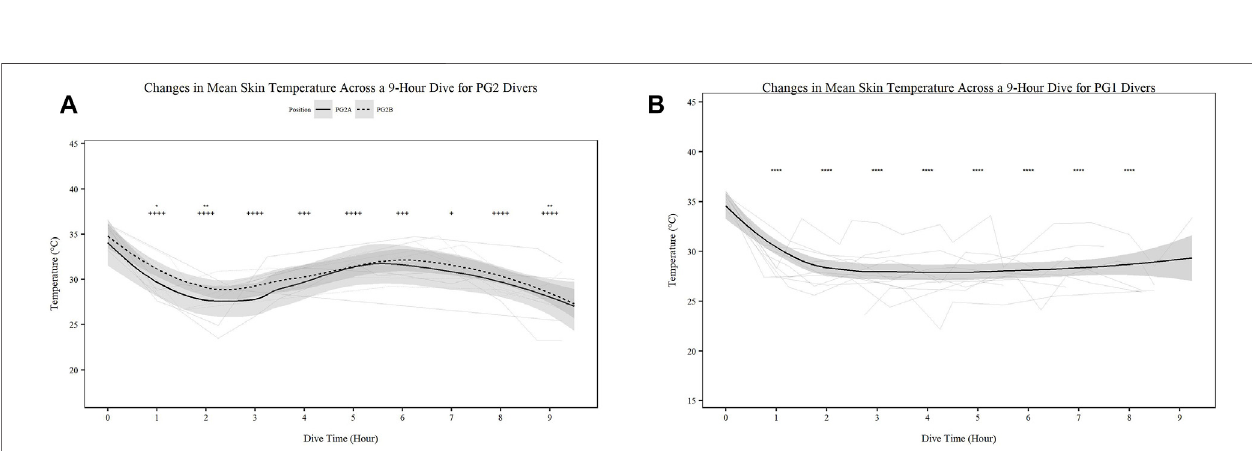
FIGURE2| Changesin Mean Skin Temperature acrossa9-h Dive forPG2A and PG2B (A) and PG1 (B) divers. Changes inskin temperature for each diver across eachdivearerepresented.PG2Baredepictedassolidlines;andpilotsandnavigatorsaredepictedasdashedlines.Thereddashedlinerepresentsthe10 ° C,thepointof risk for non-freezing cold injuries. * p < 0.05, ** p < 0.01, *** p < 0.001, **** p < 0.0001; * = PG2A, + = PG2B. All comparisons are in relation to Hour 0. Trend line created using loess function with standard error band.